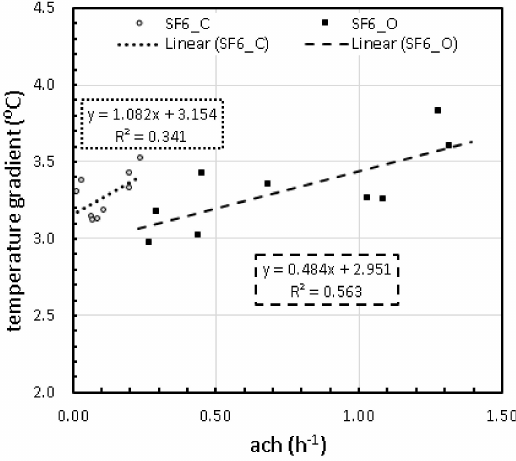
Figure12. Airchangerateversusindoor–outdoortemperaturegradient: Sulfurhexafluoride(SF 6 )—only temperature di ff erences higher than 3 ◦